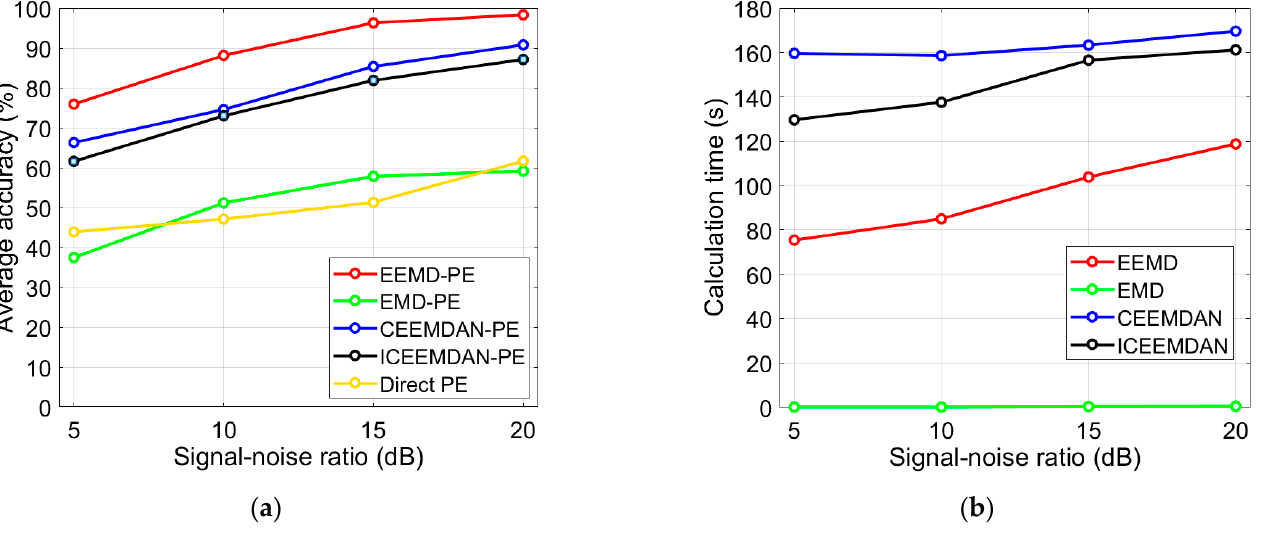
Figure 8. Comparation of different methods to highlight EEMD. ( a ) Comparation of average diagnostic accuracy; ( b ) Comparation of calculation time.